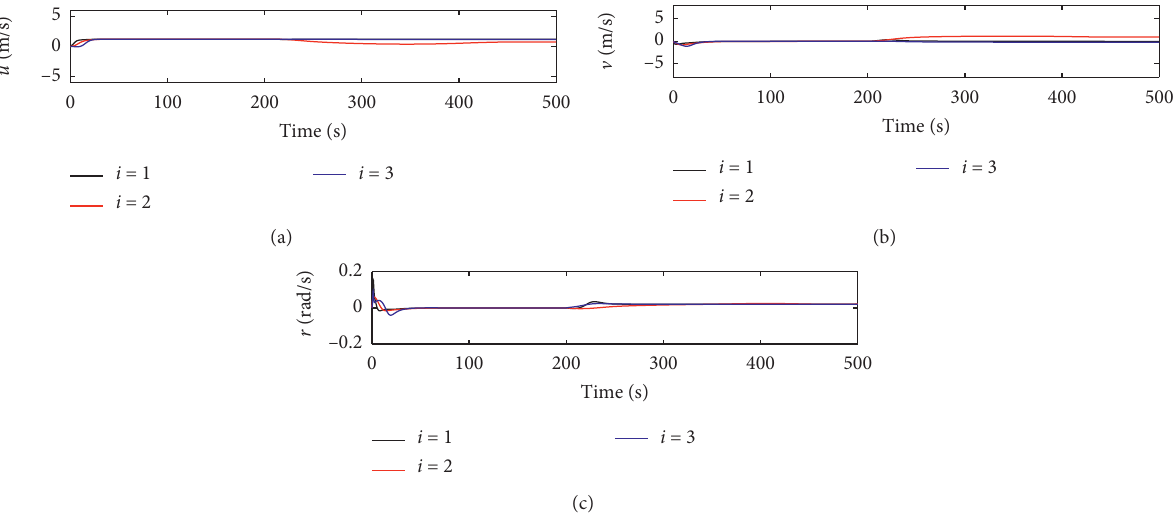
Figure 7: Velocities of the